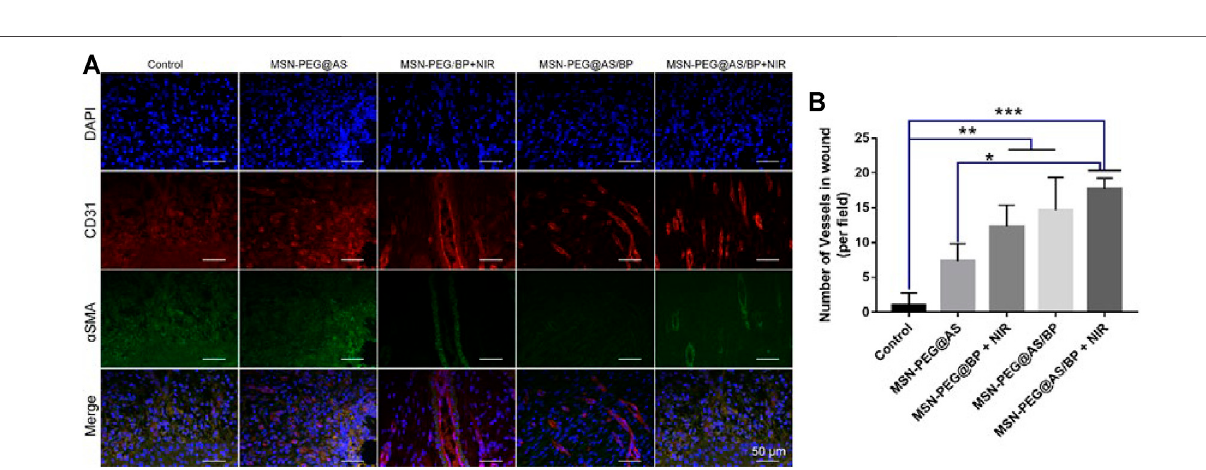
Frontiers in Bioengineering and Biotechnology |